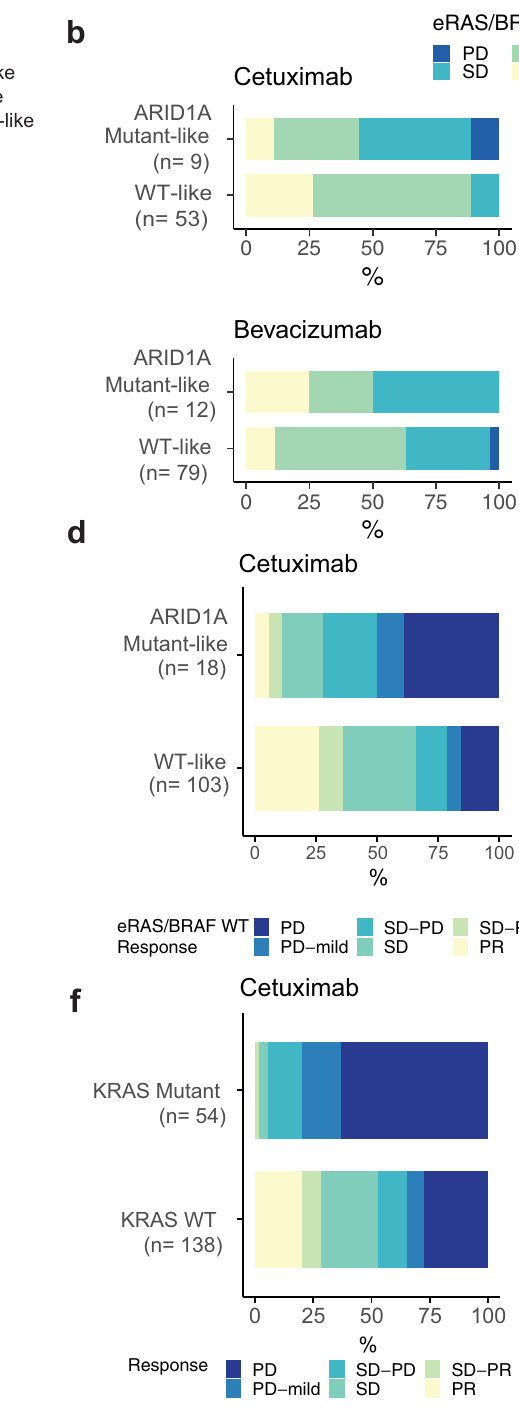
Fig.3|ARID1Amutant-likesignatureenrichesforcetuximab-resistantpatients in eRAS/BRAF WT tumors. a Kaplan – Meier curves showing OS in n =162 eRAS/ BRAF WT patients strati fi ed by ARID1A signature group (mutant-like vs. WT-like), using the signature score Q4 cutoff, and by treatment arm with p -values from log- rank test shown. b Clinical response (best RECIST) to cetuximab ( top ) and bev- acizumab ( bottom ) was strati fi ed by ARID1A mutant-like signature group for the n =153 CALGB/SWOG 80405 eRAS/BRAF WT patients with RECIST response, RNAseq and FMI alterations data available. PD, progressive disease; SD, stable disease; PR, partial response; CR, complete response. CR and PR cases were con- sidered respondersand SDand PD cases non-respondersto treatment. a , b Source